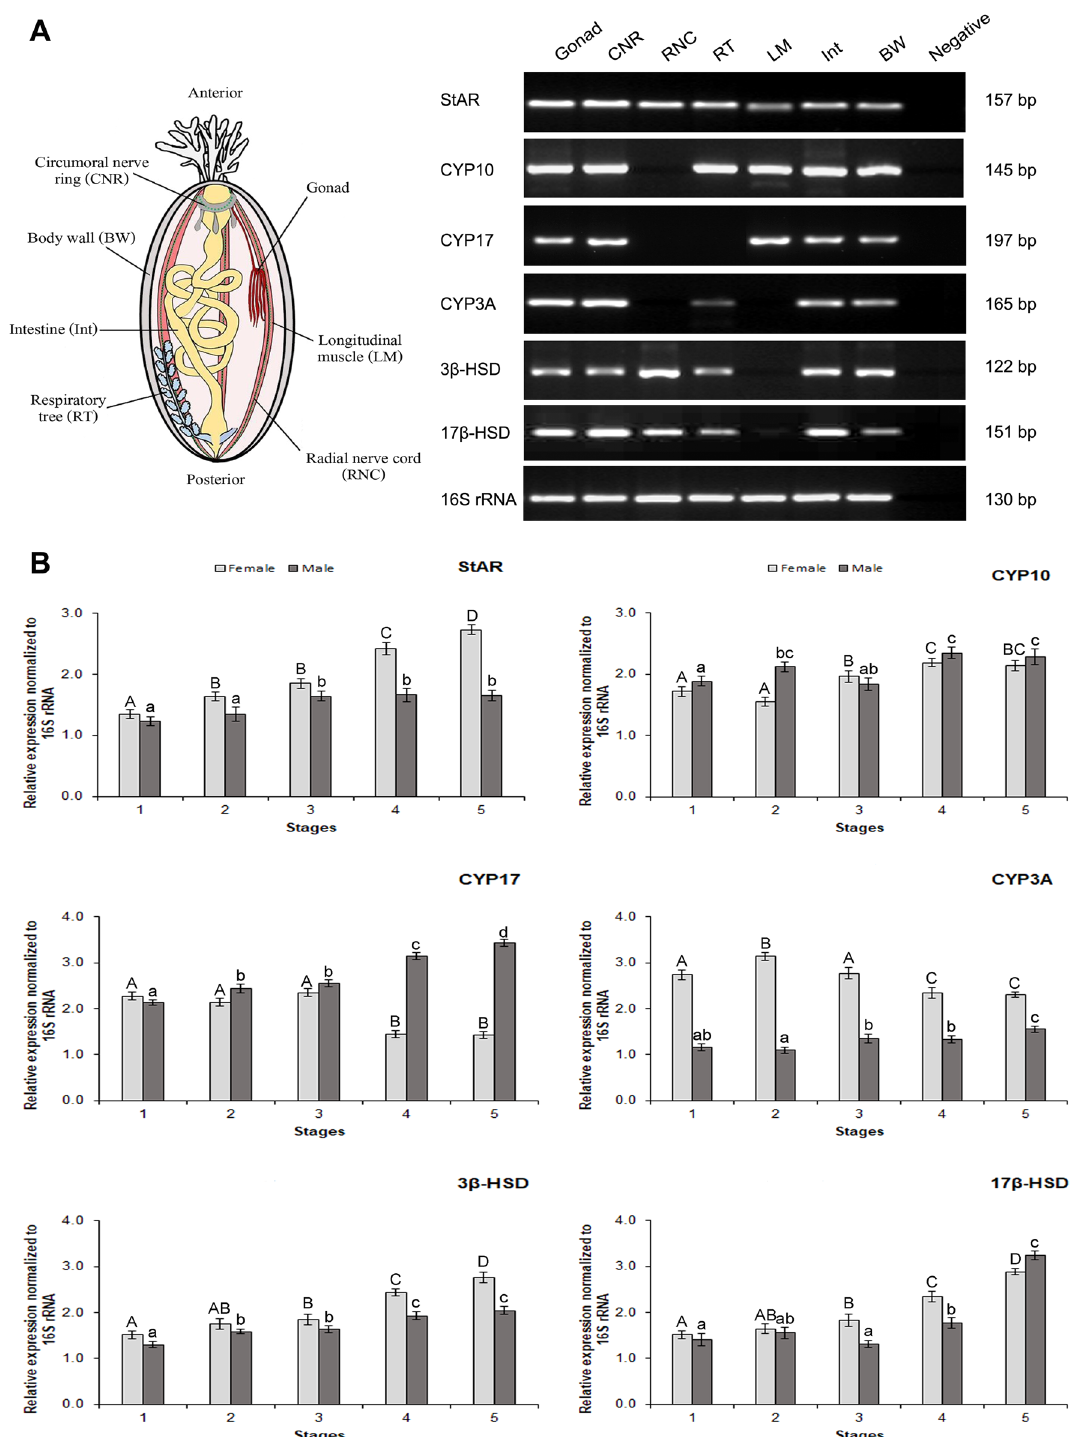
Figure 6. Tissue distribution and quantitative analysis of target genes involved in steroidogenesis in H. scabra. ( A ) Left—Schematic of sea cucumber showing tissues analysed by RT-PCR. Right—Agarose gel showing amplicons for StAR; steroidogenic acute regulatory protein, CYP10; cytochrome P450 10, CYP17; 17α-hydroxylase/17,20-lyase, CYP3A; cytochrome P450 3A, 3β-HSD; 3β-hydroxysteroid dehydrogenase, 17β-HSD; 17β-hydroxysteroid dehydrogenase, 16S rRNA; internal control, and negative; no RT-template. ( B ) Quantitative expression profiles in gonadal tissues of H. scabra during reproductive maturation (stages 1–5) (n = 10 for each sex at each stage). Data were normalized against 16S rRNA and the relative expression levels represented by the mean ± SD. Different letters indicate significant difference (p < 0.05) among reproductive stages of females (capital letters) and males (small letters) H. scabra